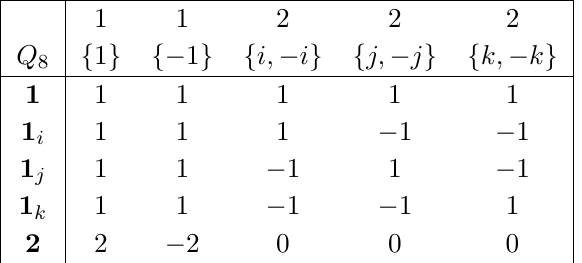
Table 3. Character table of Q 8 , the quaternion group. The column are labelled by the conjugacy classes with the numbers of elements in each class